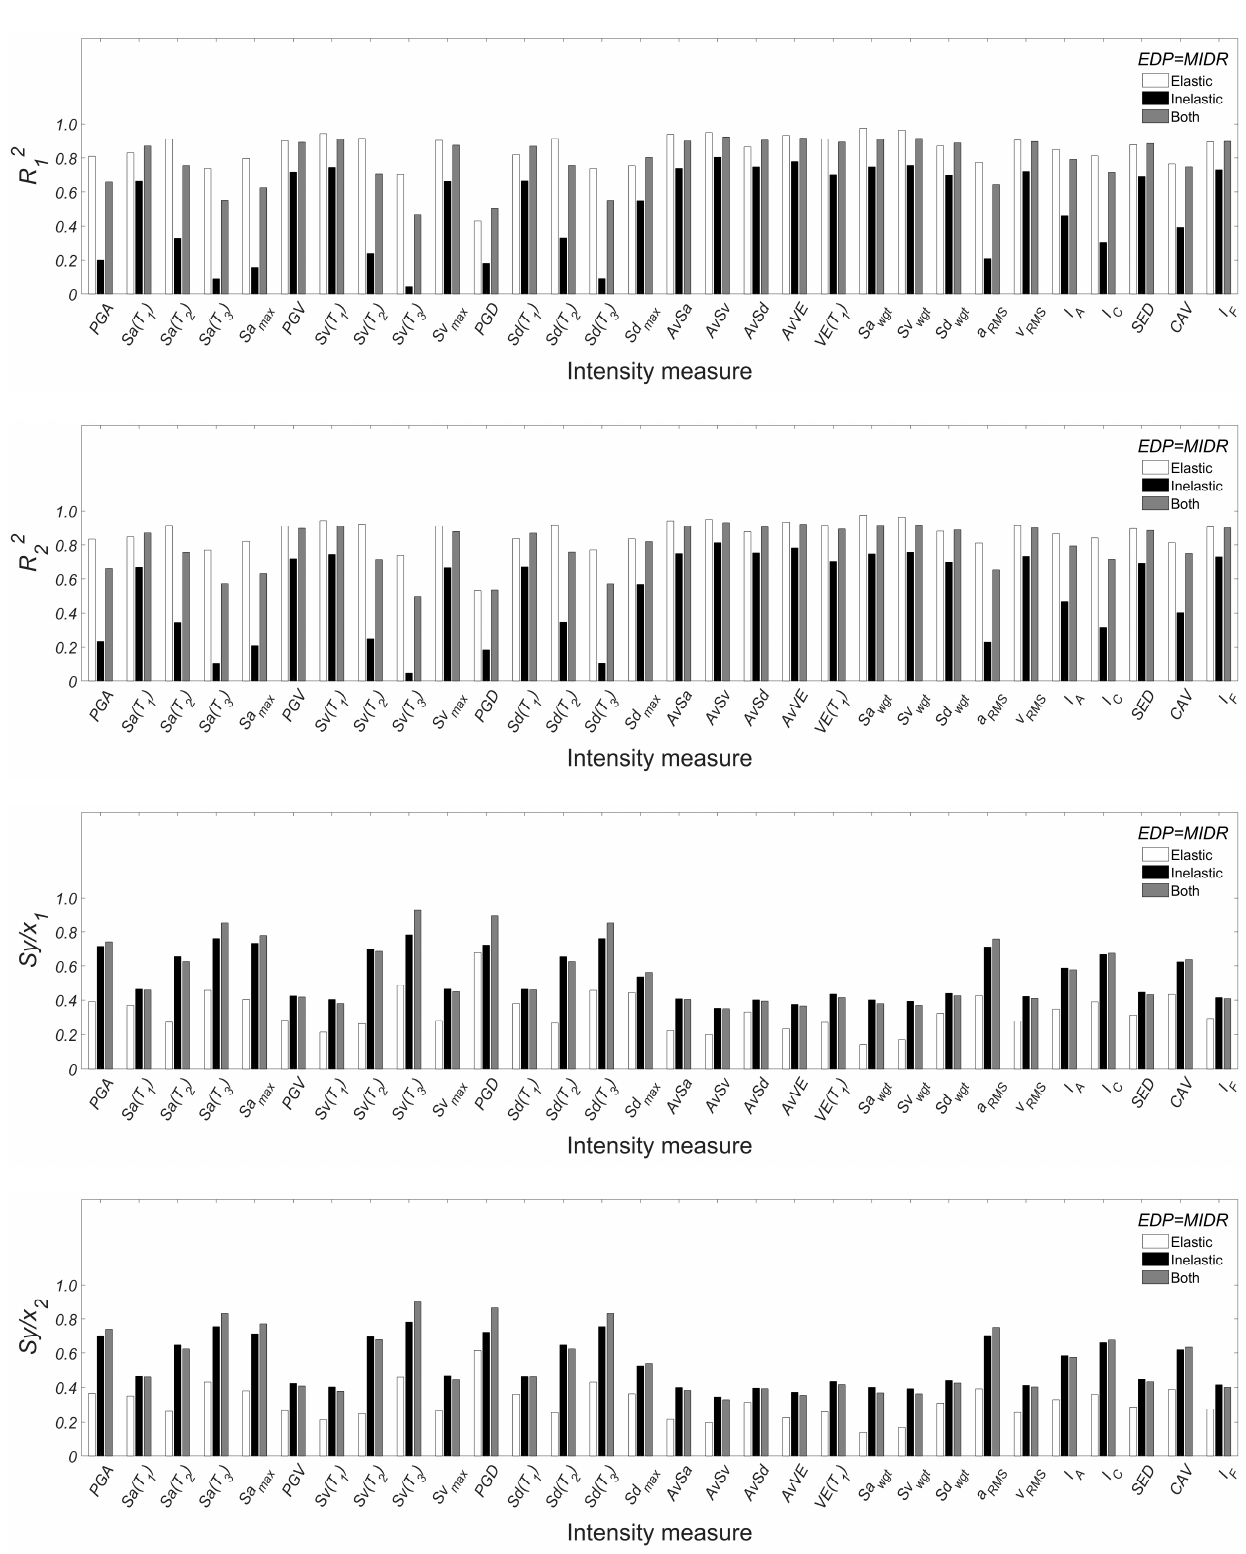
Figure A2. Statistical results by considering as EDP to MIDR.